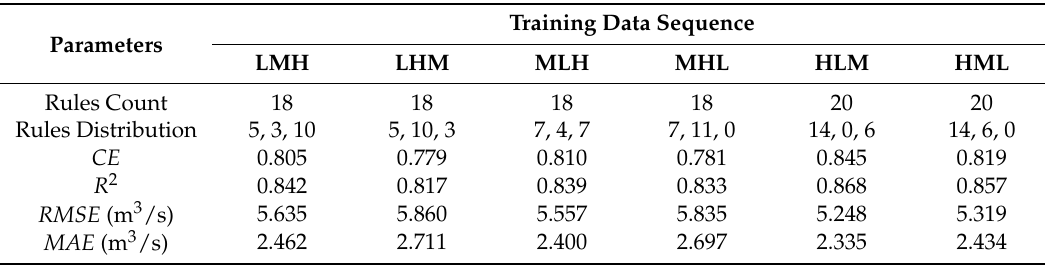
Table 7. Rules count and average DENFIS performance in simulating the 18 testing events of